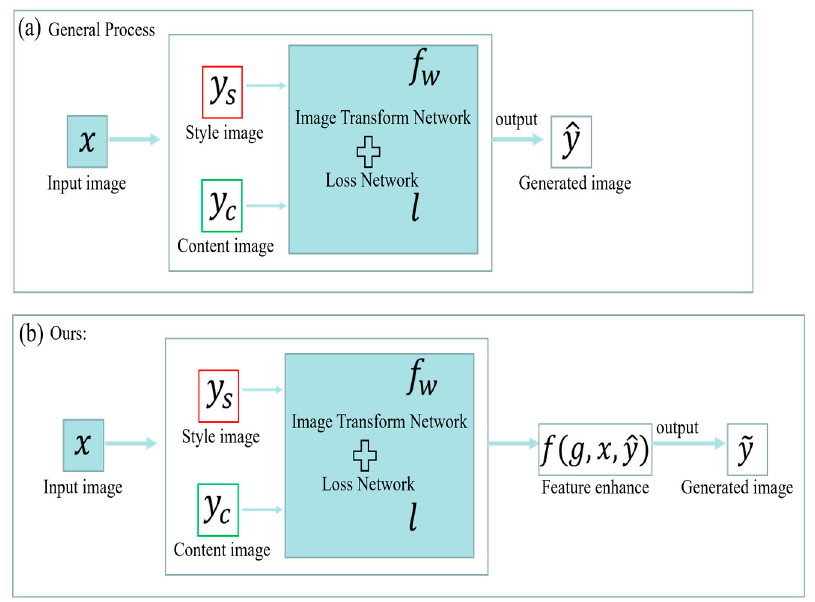
Figure 10. Style transfer process. ( a ) General style transfer process. ( b ) Enhancement feature based on style transfer.